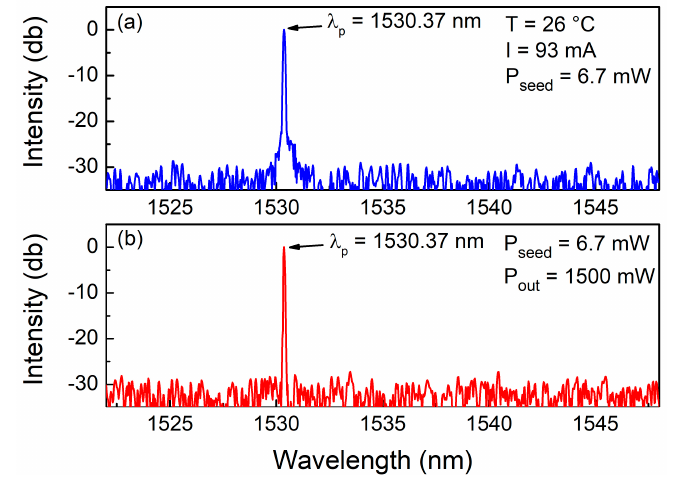
Figure 3. Emission spectra for a seed laser and an EDFA-amplified diode laser.